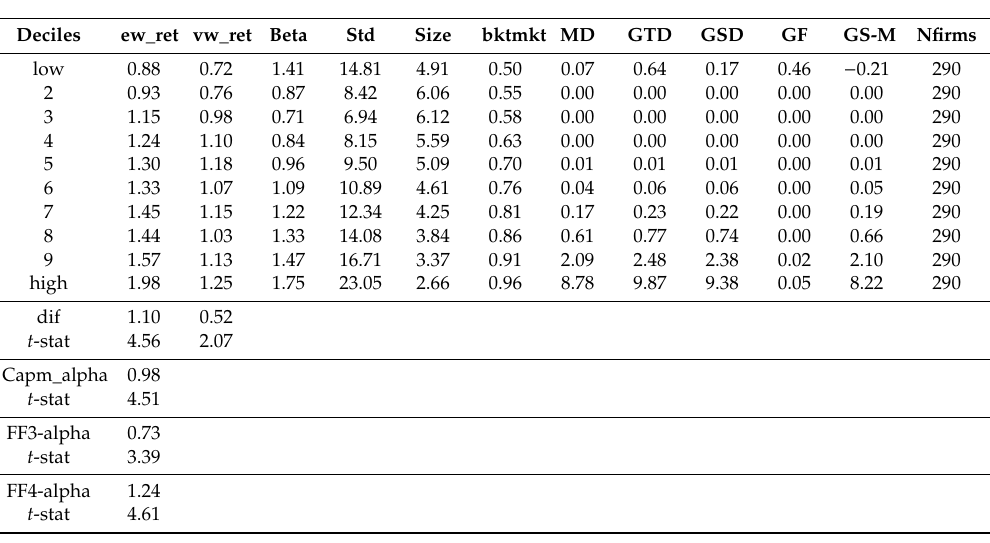
Table 6. Average returns from decile portfolios sorted by Geske’s short-term minus forward default probability. From the data for July 1963 to December 2013, at the end of each month, we used the most recently calculated Geske’s short-term minus forward default probability for each firm to sort all stocks into deciles. We then calculated the equally weighted and value-weighted returns over the next month. The returns are the average monthly returns over the sample period. Portfolio 1 is the portfolio with the lowest default risk and Portfolio 10 is the portfolio with the highest default risk. High-Low is the di ff erence between the high and low default risk portfolios. t -values are calculated from Newey-West standard errors. Alphas are calculated using the CAPM, the three-factor Fama-French and the four-factor model (Fama-French three-factor plus